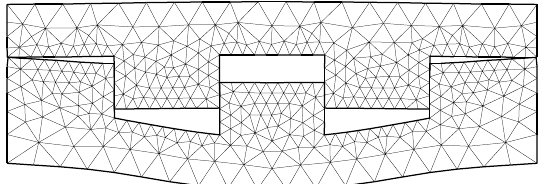
Figure 6.10 . Deformed configuration of the two viscoelastic bodies for µ = 0 . 5ns/m 2 and η = 0 . 2ns/m 2 .